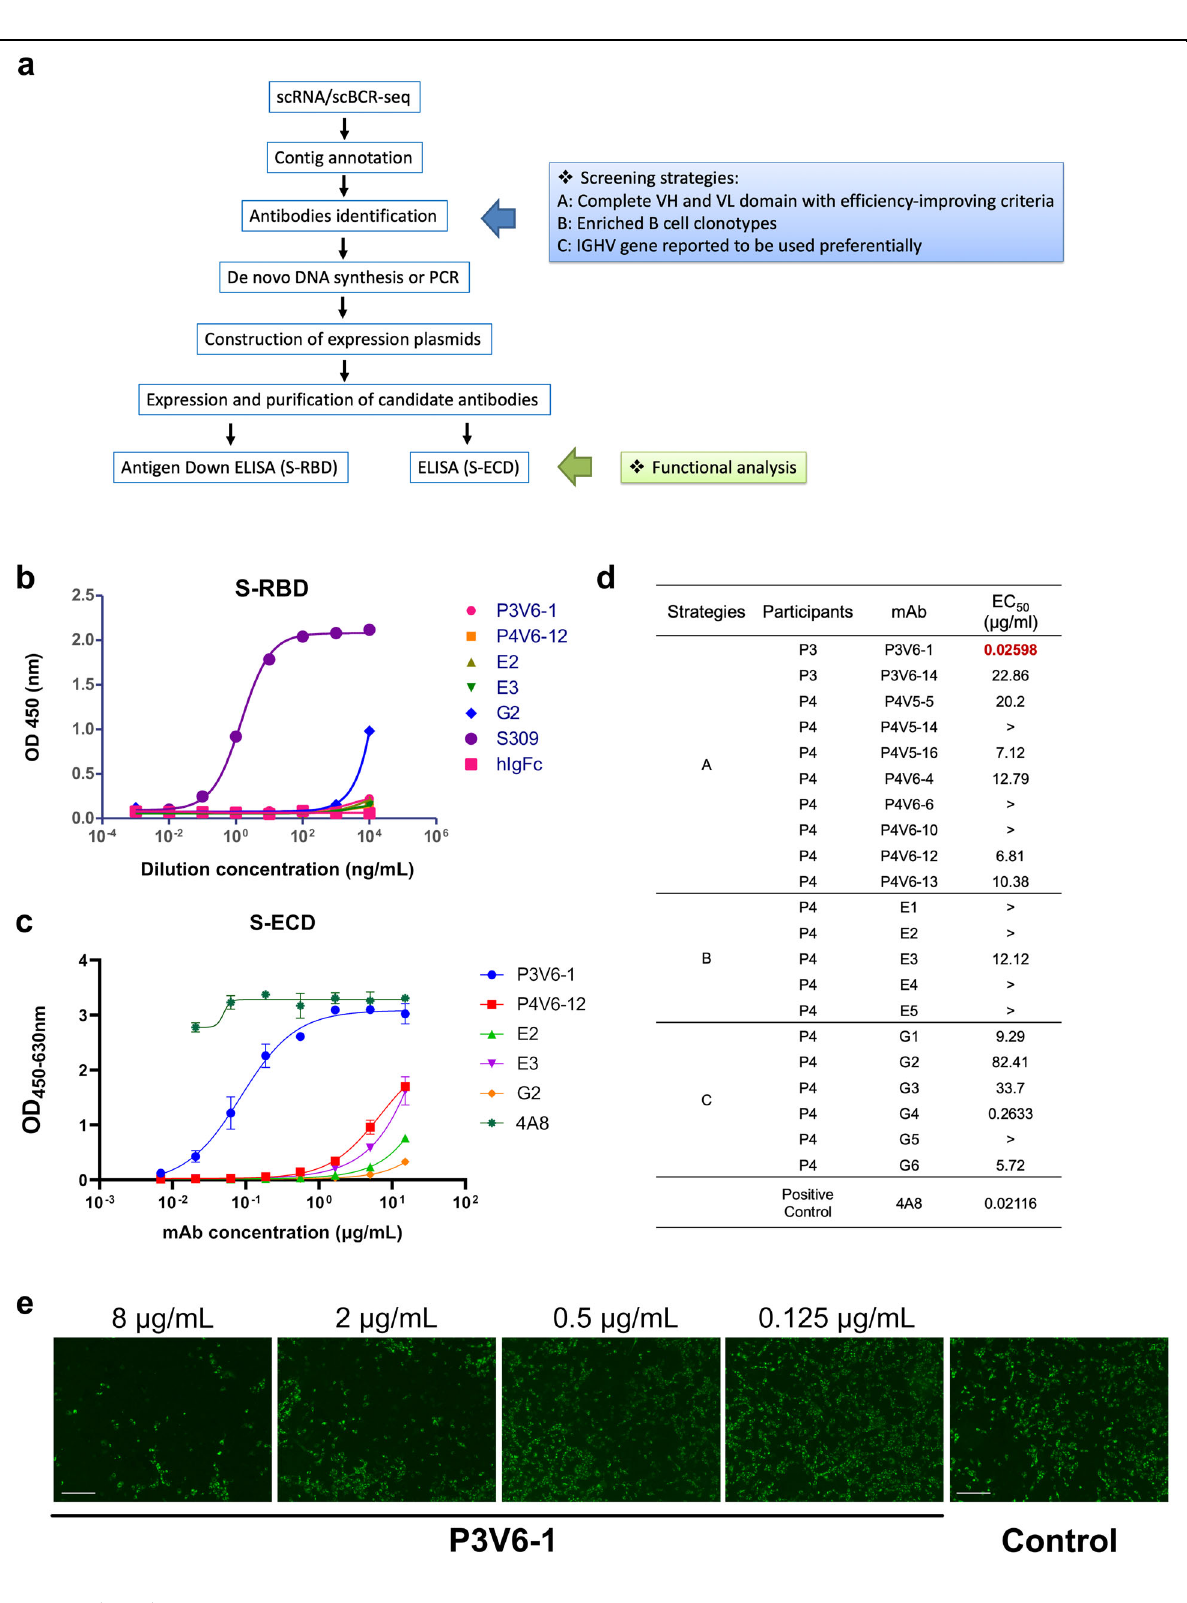
Fig. 3 (See legend on next